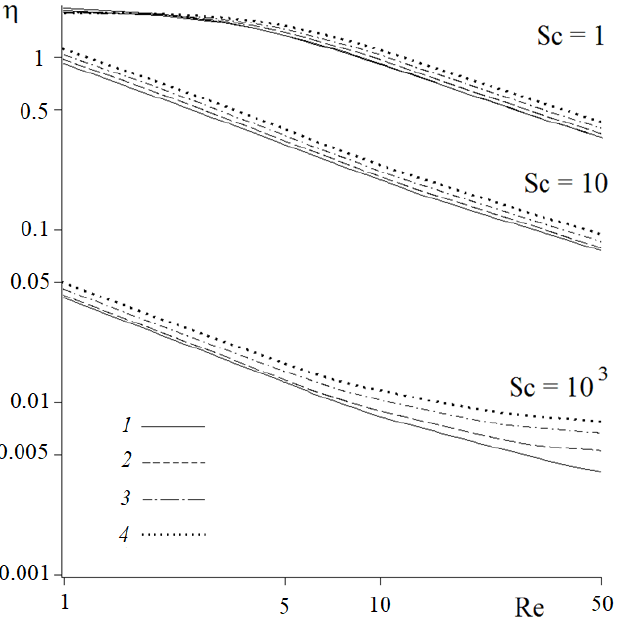
Figure 3. Retention efficiencies for a profiled fiber with protrusion obstacles vs. Reynolds number at different values of the Schmidt number (given in the Figure); the thickness of the protrusion is 0.1 and the heights of the protrusions are 0.1 ( 1 ), 0.2 ( 2 ), 0.3 ( 3 ), 0.4 ( 4 ); a / h = 0.5.